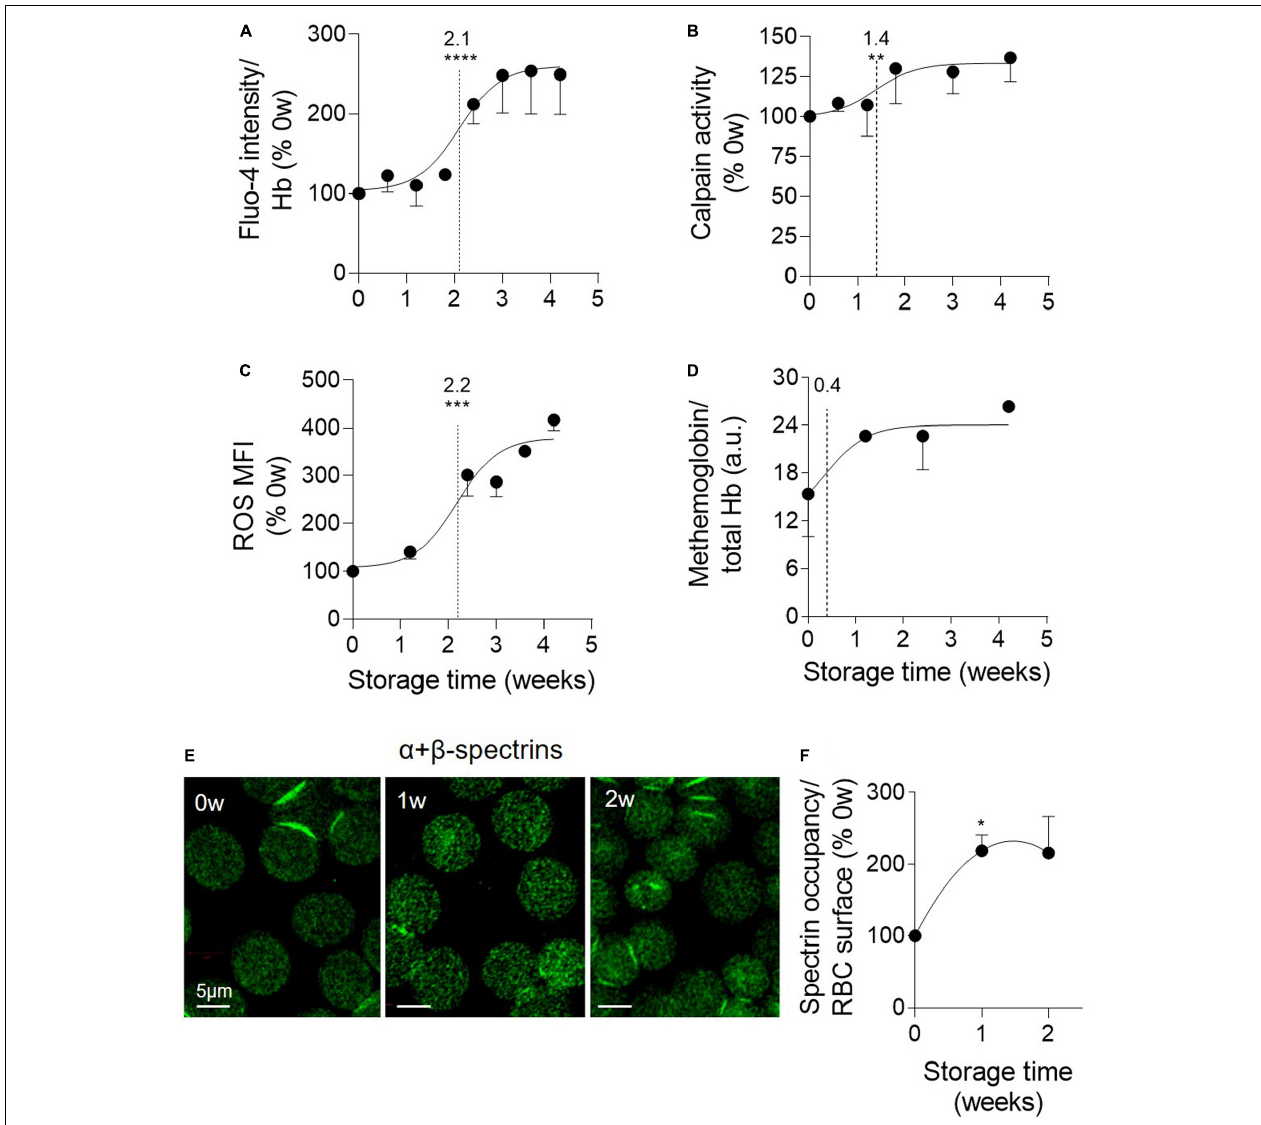
FIGURE 3 | Oxidized hemoglobin and spectrin density rapidly increase upon storage while calpain activity increase and accumulation of calcium and reactive oxygen species take place later. RBCs stored for the indicated times at 4 ◦ C in K + /EDTA tubes were isolated and analyzed for intracellular calcium (A) , active calpain (B) , reactive oxygen species (ROS; C ), methemoglobin (metHb) content (D) and spectrin occupancy at the RBC surface (E,F) . The time needed to reach 50% effect and the statistical analysis (Mann–Whitney U test) are indicated above the vertical dotted line [except in (F) in which the comparison was done vs. the 0 week]. (A) RBC calcium content. RBCs were incubated with the non-fluorescent Fluo-4 AM and then in Fluo-4 AM-free medium to allow for probe de-esterification and calcium binding, generating fluorescent Fluo-4 measured at 494 nm. Data were normalized on the Hb content and expressed in % of 0 weeks of storage. Means ± SEM of 7 independent experiments. (B) µ -calpain activity. Lysates of isolated RBCs were incubated with the substrate of calpain which emits fluorescence at 505 nm upon cleavage. Data are expressed as % of 0 weeks of storage and are means ± SEM of 6 independent experiments. (C) RBC ROS content. RBCs were labeled with H 2 DCFDA, which is transformed into fluorescent 2,7-dichlorofluorescein (DCF) after de-esterification and interaction with intracellular ROS, and then analyzed by flow cytometry. Median fluorescence intensity (MFI) as % of 0 weeks of storage. Means ± SEM of 3 independent experiments. (D) MetHb determination. RBCs were assessed for metHb concentration by a sandwich ELISA. Data were then normalized to the total Hb content. Means ± SD of 2 independent experiments. (E,F) Membrane:spectrin occupancy. RBCs were immunolabeled for pan-spectrin, analyzed by confocal microscopy (E) and quantified for spectrin occupancy per RBC surface (F) . Data were expressed as % of 0 weeks of storage and are means ± SEM of 3 independent experiments. * p < 0.05; ** p < 0.01; *** p < 0.001; **** p <